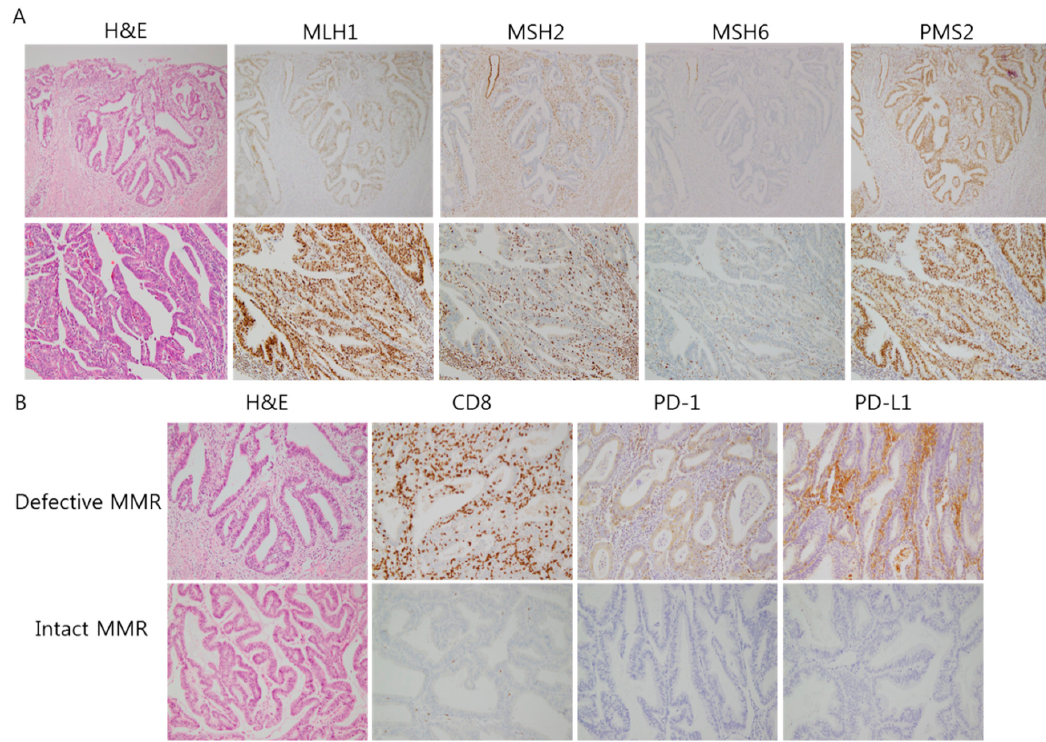
Figure 1. ( A ) Immunohistochemistry of four mismatch repair (MMR) proteins, showing the expression of MLH1/PMS2 and loss of MSH2/MSH6 (upper: ×100, lower: ×200). ( B ) Immunohistochemistry of CD8, PD-1, and PD-L1, showing differential peritumoral expression between defective and intact MMR proteins (×200). Table 1. Baseline clinical and pathologic characteristics of the study population. Table 2. Comparison of clinicopathologic characteristics, according to DNA mismatch repair (MMR) status and probable Lynch syndrome (PLS) (versus sporadic